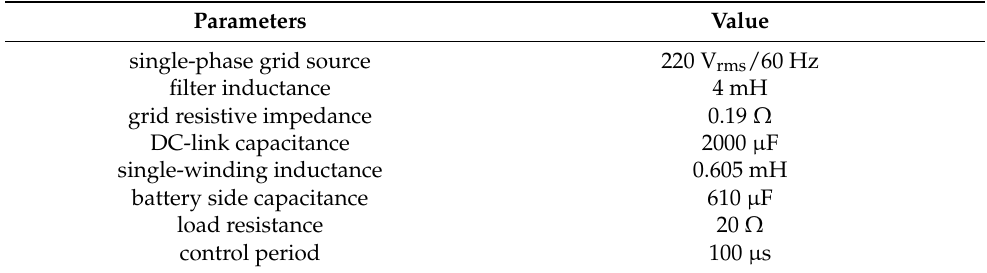
Table 3. Simulation parameters.